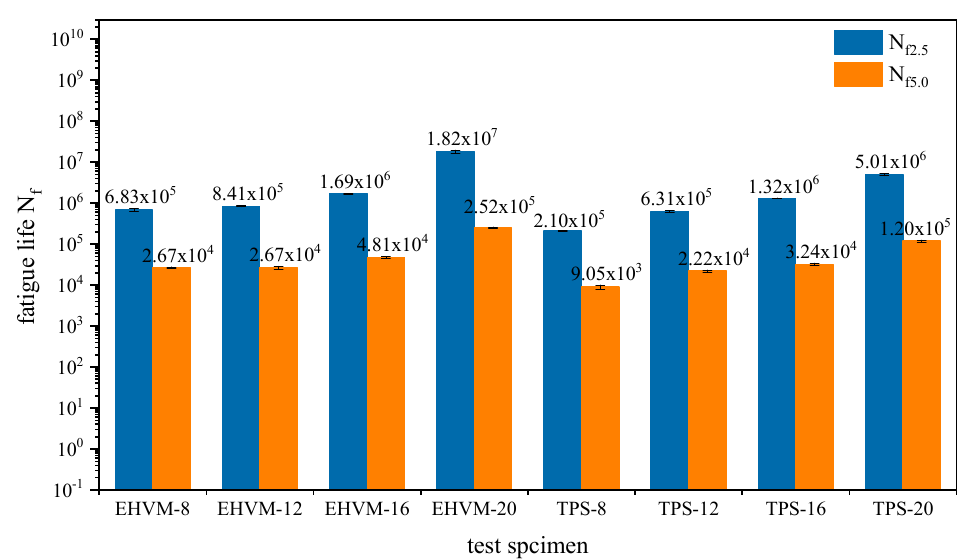
Figure 9. Fatigue life from the LAS test at 2.5% and 5.0% strain levels.